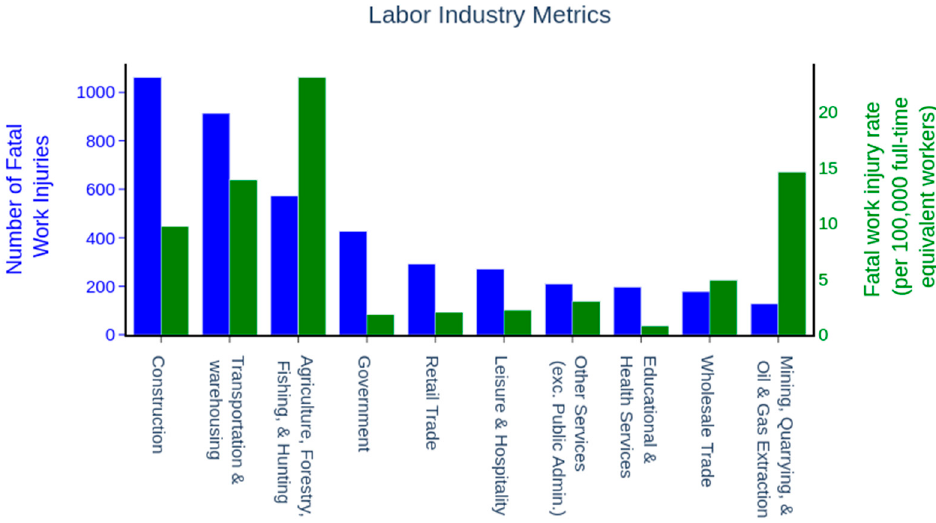
Figure 5. U.S. Bureau of Labor Statistics 2019 survey on the rate of fatal work injury by industry sector [39]. The x -axis is the fatal work injury rate and the y -axis is different industries.